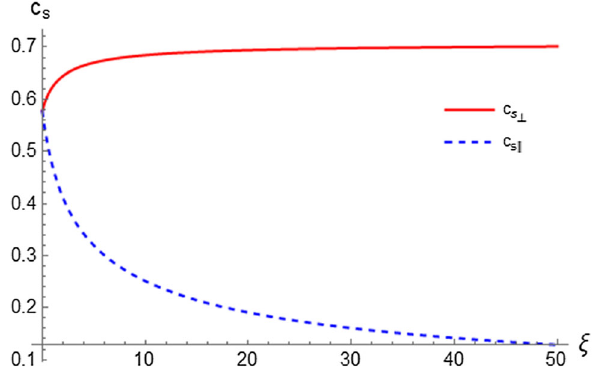
Fig. 2 Plots of the transverse c s ⊥ (39) (solid) and longitudinal c s (cid:5) (46) (dashed) speed of sound as functions of the anisotropy parameter ξ in units of the speed of light